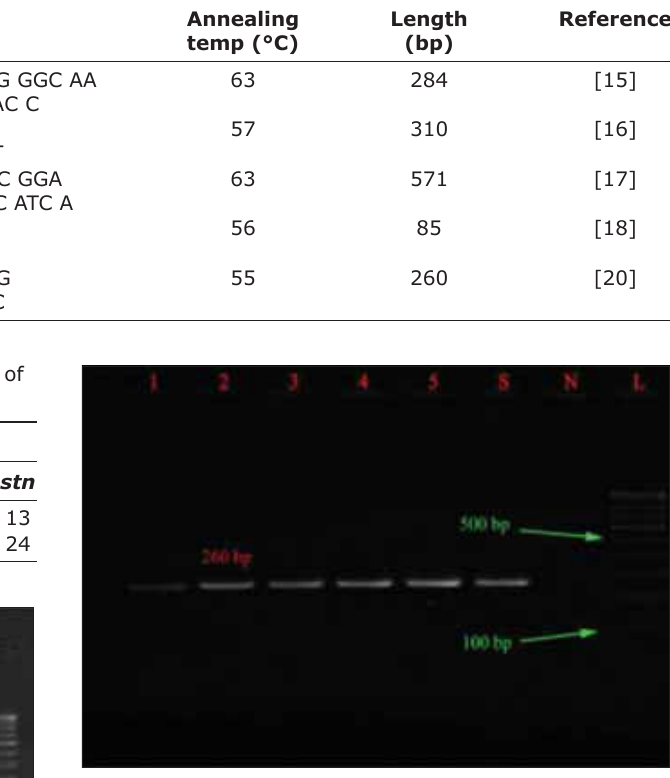
Figure-3: Agarose gel showing polymerase chain reaction amplification products of stn gene (260 bp).